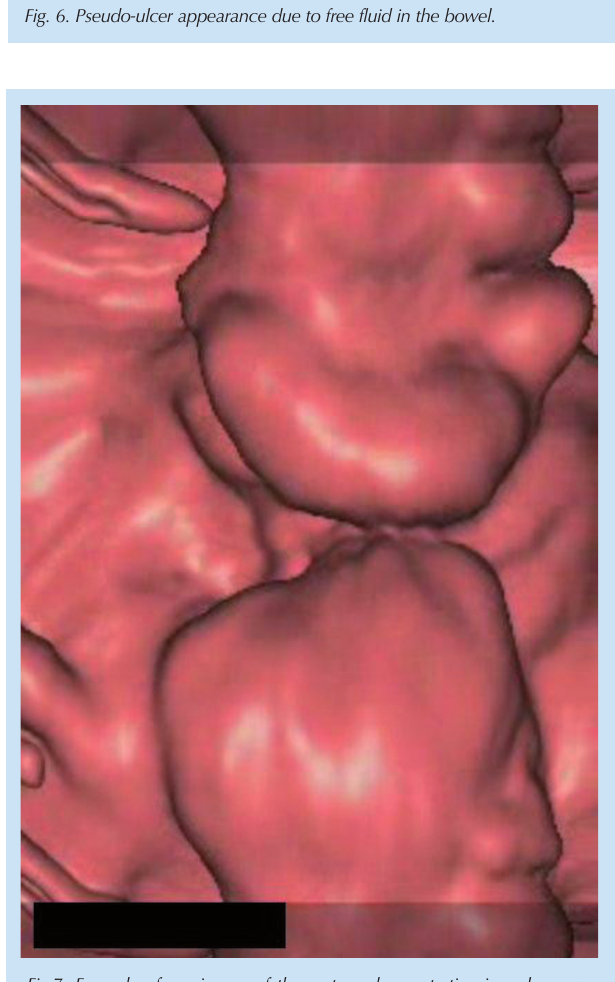
Fig.7. Example of carcinoma of the rectum demonstrating irregular mass with narrowing of the